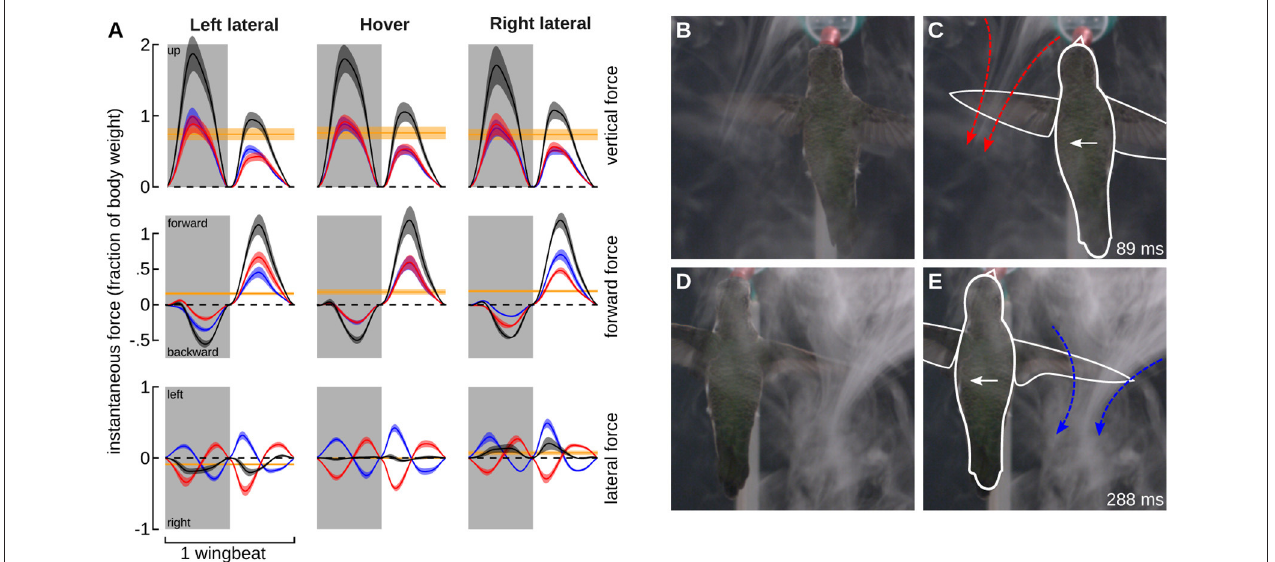
FIGURE 6 | Quasi-steady aerodynamic analysis and smoke visualization demonstrate that hummingbirds “track” a laterally moving feeder by generating flight forces that oppose its motion. (A) The instantaneous vertical (top row), forward (middle row), and lateral (lower row) forces were calculated using a blade-element analysis. The forces based on the average wingbeat kinematics ( Figure 5 ) are shown for feeder tracking to the left (left column), hovering (middle column), and feeder tracking to the right (right column). Instantaneous forces generated by the left (red) and right (blue) wings, and the net force (black) are expressed relative to body weight. The net force over the whole wingbeat and along each axes is depicted by the solid yellow line. Lines represent average values and transparent bands indicate the standard errors of the mean calculated across birds. The timing for all average traces is normalized by down- and up-stroke, with each representing 50% of the wingbeat. Downstrokes are represented in gray and upstroke are represented in white. Bird #7 was filmed from the dorsal perspective during feeding tracking to the left in the presence of a CO 2 plume created by the sublimation of dry ice. The complete video is available in the online Supplementary Materials ( Video S2 ). The frame at 89ms provides a view of the jet generated by the left (leading) wing immediately after mid-downstroke. This frame is provided twice, once as an unmanipulated image (B) and again with the outline of the bird (white) and the jet (red) included (C) . The frame at 288ms from the same video provides a view of the jet generated by the right (trailing, blue) wing immediately after mid-downstroke. Unmanipulated (D) and outlined (E) images are provided. The feeder was moving at 30